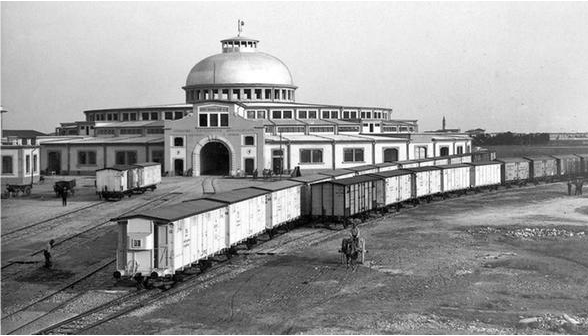
Figure 1. View of the Ex Stazione Frigorifera in the